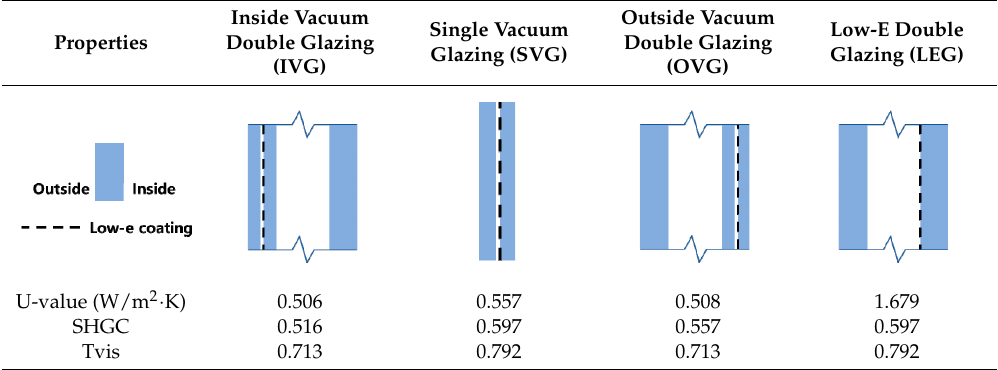
Figure 4. Measured temperature profiles with the SVG and LEG (8–9 April 2017).